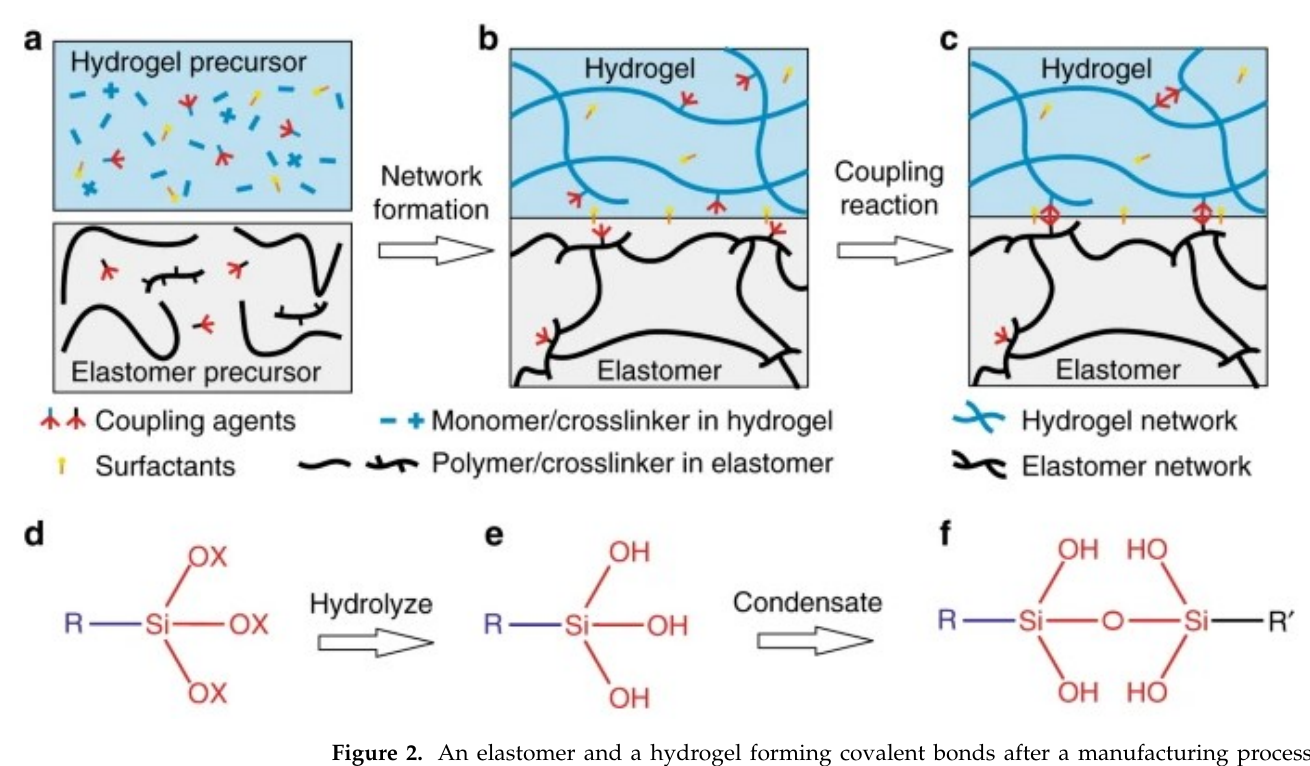
Figure 2. An elastomer and a hydrogel forming covalent bonds after a manufacturing process. ( a ) Silane coupling agents are mixed into the precursors of a hydrogel and an elastomer separately. ( b ) During the formation of the two networks, the coupling agents are covalently incorporated into the networks, but do not condensate. ( c ) After a manufacturing process, the coupling agents condensate, add crosslinks in the individual networks, and form bonds between the networks. A surfactant may further promote adhesion. ( d ) Silane coupling agents hydrolyze and form ( e ) silanol groups, which condensate to form ( f ) siloxane bond. Reproduced from [39] with permission. Copyright 2018 Qihan Liu et al.